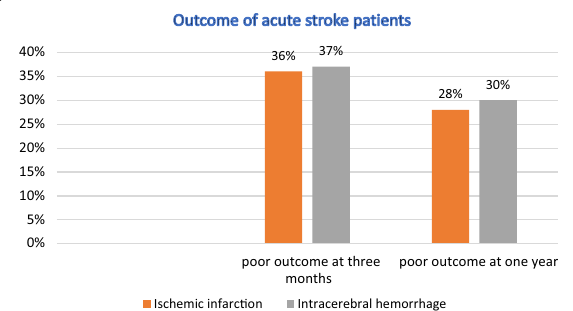
Fig. 1 Outcome of ischemic and hemorrhagic stroke patients at 3 months and after 1 year of stroke onset